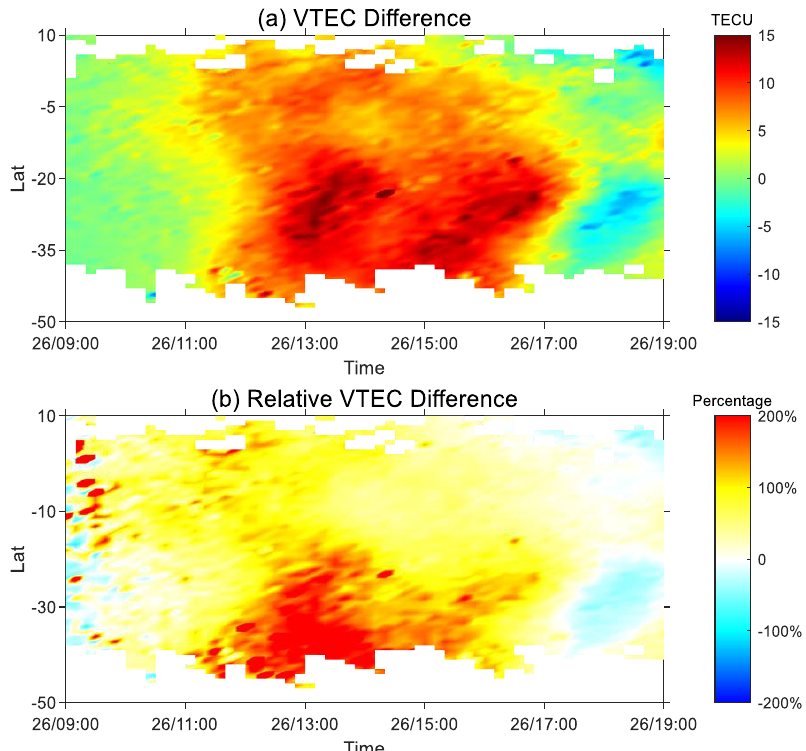
Figure 6. Latitude/time variation of ( a ) VTEC difference and ( b ) relative VTEC difference of Storm-2 from 10° N to 50° S at 50° W.